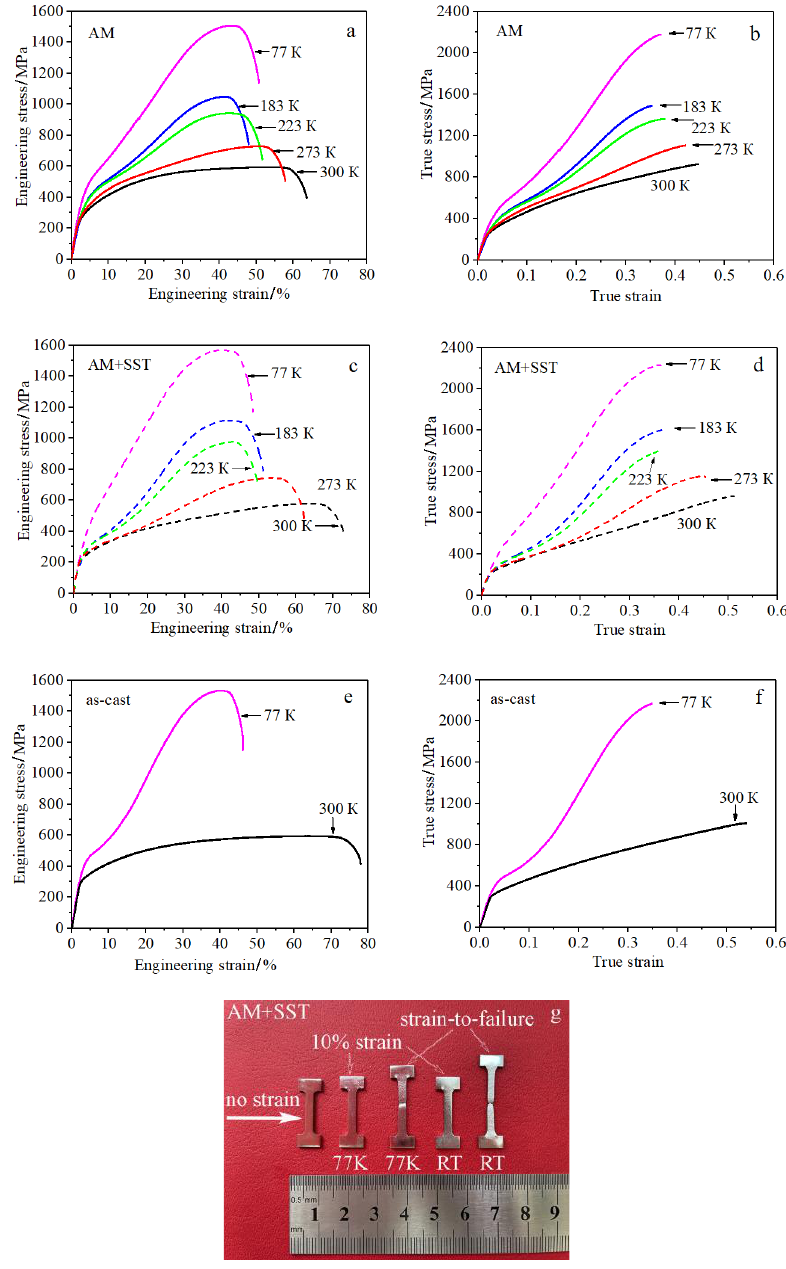
Figure 2. Tensile diagrams in the engineering ( a , c , e ) and true ( b , d , f ) coordinates for the AM ( a , b ), AM + SST ( c , d ) and the as-cast ( e , f ) samples. Common view of the AM + SST samples before strain, after 10% strain and after the failure at room temperature (RT) and at 77 K ( g ). Test temperatures are given in the figures.